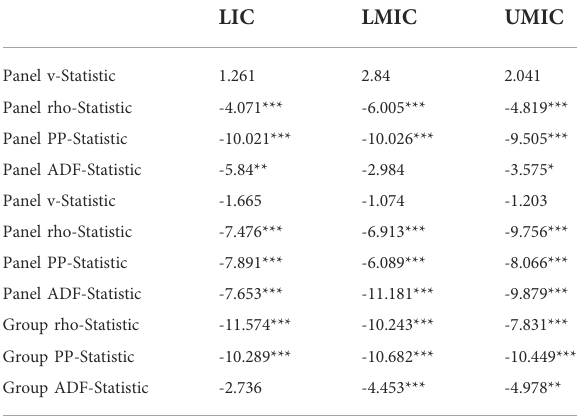
TABLE 4 Panel cointegration test.